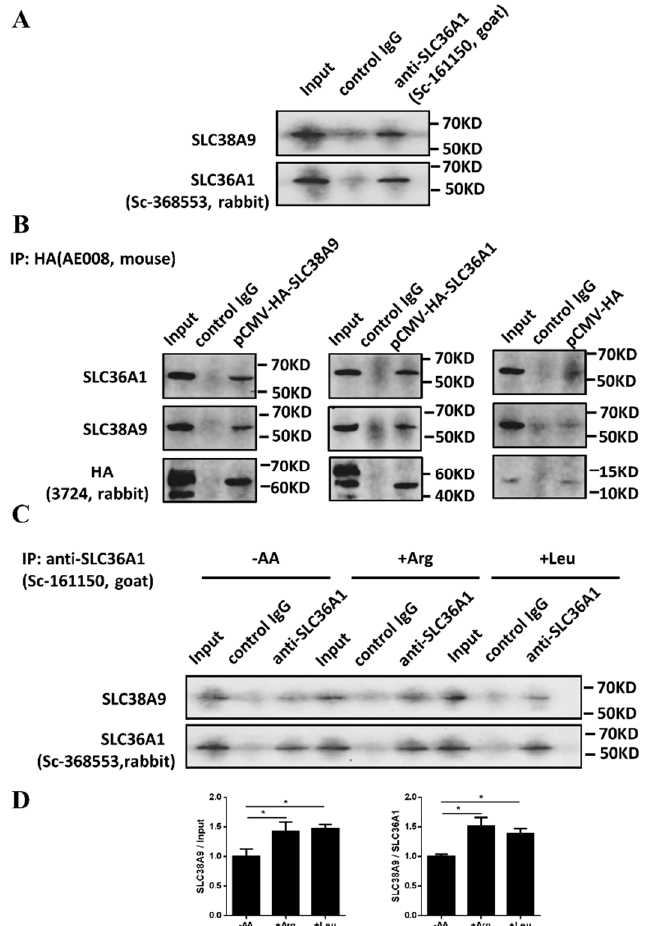
Figure 5. SLC38A9 and SLC36A1 interact. ( A ) SLC38A9 was associated with SLC36A1 at the endogenous level as detected by Co-IP: anti-SLC36A1 (sc-161150, Santa Cruz) was used for pull-down, and anti-SLC38A9 (ab81687, Abcam) and anti-SLC36A1 (sc-368553, Santa Cruz) were used for detection. ( B ) Interaction of SLC38A9 and SLC36A1: C2C12 cells were transfected with SLC38A9 or SLC36A1 in the pCMV-HA vector, and the lysates were prepared and subjected to HA immunoprecipitation followed by immunoblotting for the indicated proteins. ( C ) C2C12 cells were pretreated without serum for 15 h, and without amino acids for 3 h, then cultured for 10 min in a special medium (Supplemental Table S1) including the no amino acids group ( − AA), the only Arg group (+Arg), the only Leu group (+Leu). The interaction of SLC38A9 and SLC36A1 was detected by Co-IP as ( A ). ( D ) Densitometric analysis of the immunodetection of SLC38A9 relative to input control or SLC36A1. Values are the mean ± SEM; n = 3; * p <